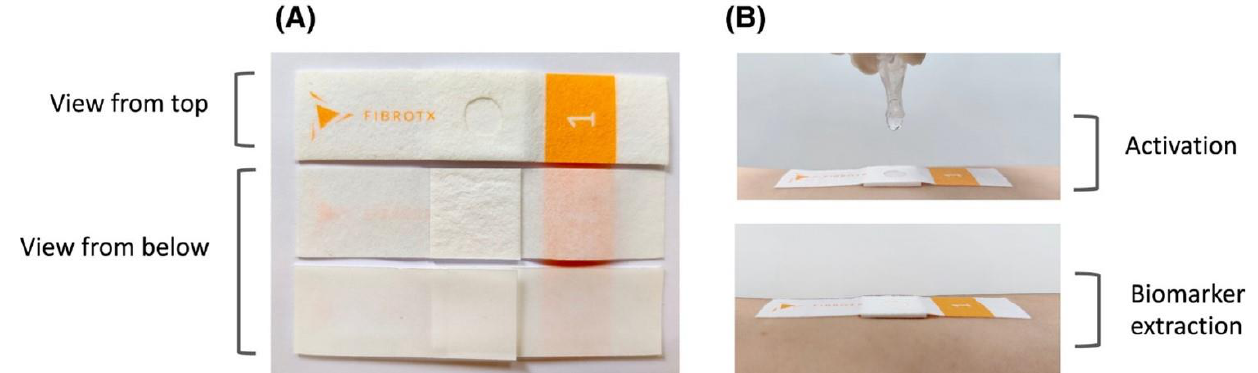
Figure 2. Tape-stripping procedure illustrated with pictures. ( A ) presents the top and bottom view of the strip and ( B ) demonstrates the activation process used to extract the biomarkers. Image reproduced with permissions from [33].